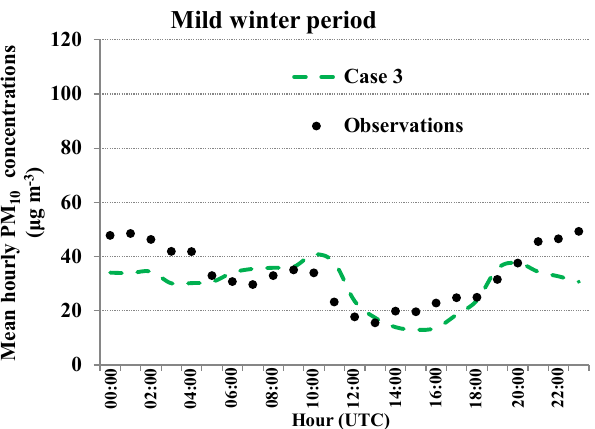
Figure 7. The mean daily cycle of PM 10 concentrations during the mild winter period from the observations (black dots) and model predictions by case 3 (green line). All data refer to the Thissio site